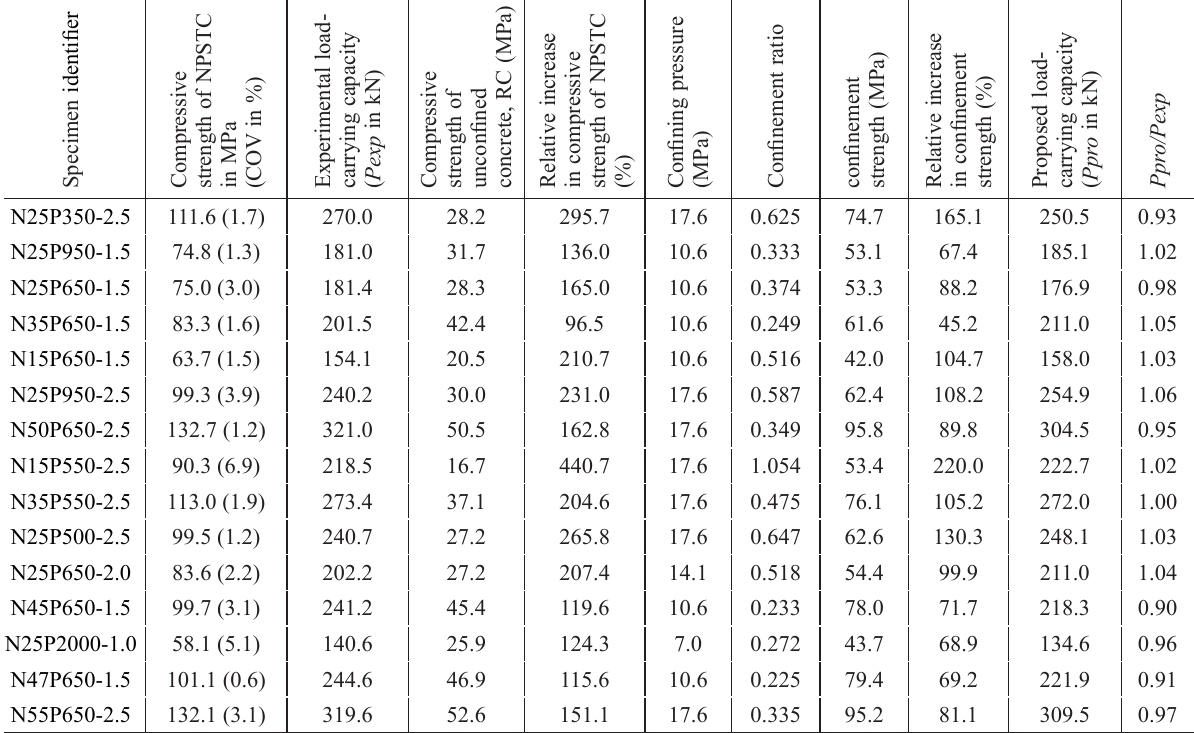
Table 3. Results of passively-confined